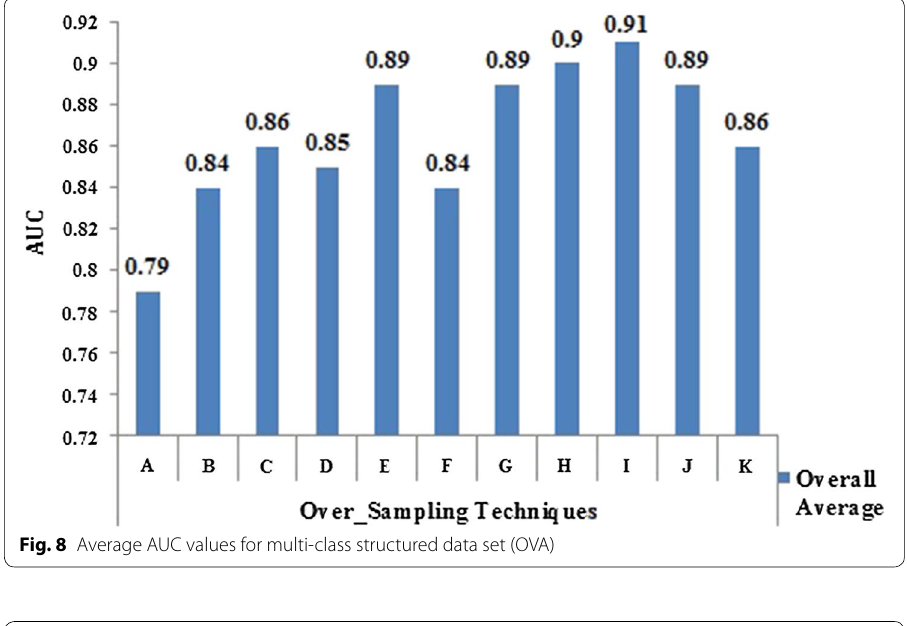
Fig. 8 Average AUC values for multi-class structured data set (OVA)